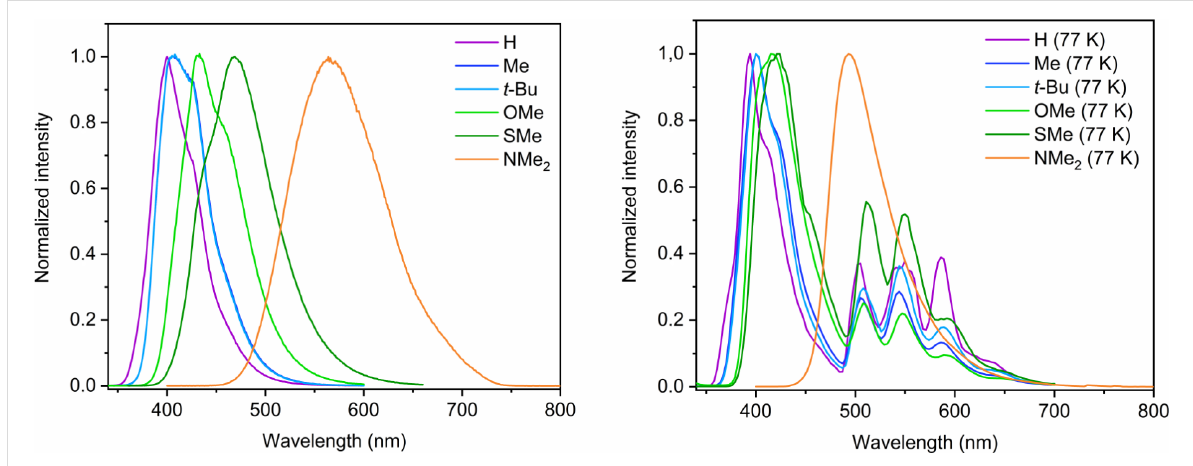
Figure 4: Normalized emission spectra of the evaluated compounds in fluid THF at rt (left) and in a frozen glassy matrices of 2-methyl-THF at 77 K; λ ex = 320 nm ( H , Me , t -Bu ); λ ex = 340 nm ( OMe , SMe ); λ ex = 350 nm ( NMe 2